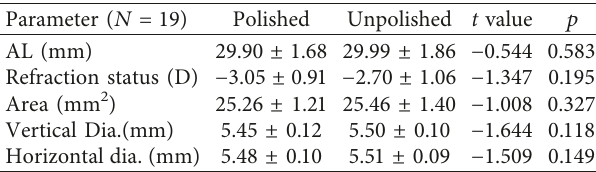
Table 1: The AL, refraction status, and anterior capsule opening size at the 1st day after surgery.